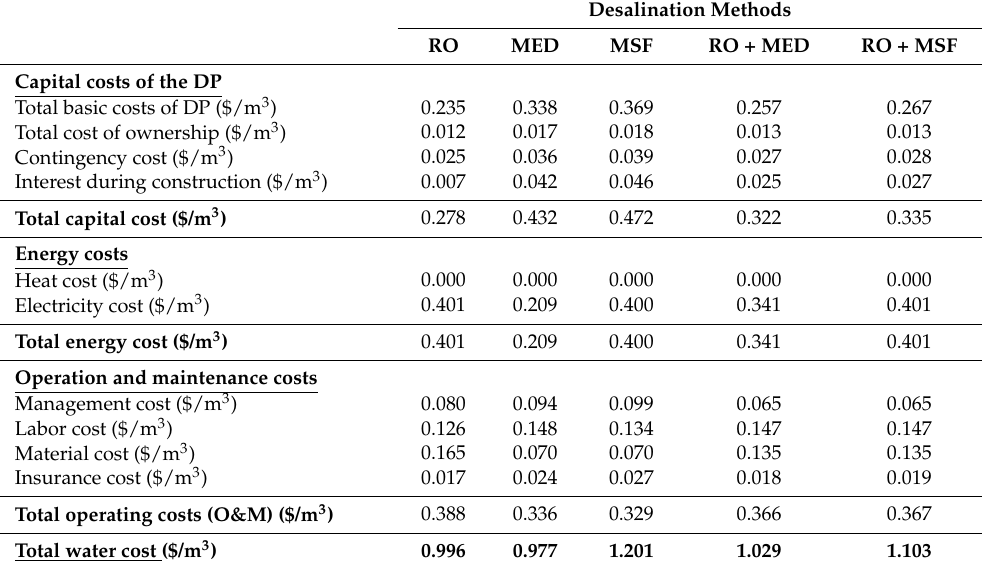
Table 5. Obtained results of economic evaluation for three standalone desalination systems and two hybrid